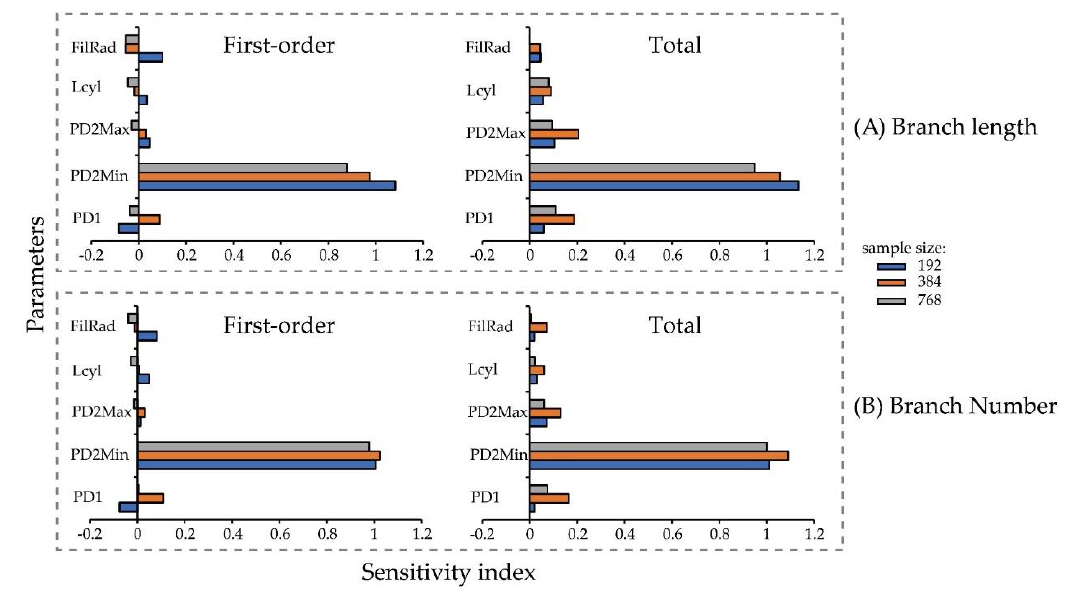
Figure 4. Three different samples and their sensitivity index. ( A ) Branch length; ( B ) branch number. Figure 4. Three di ff erent samples and their sensitivity index. ( A ) Branch length; ( B ) branch